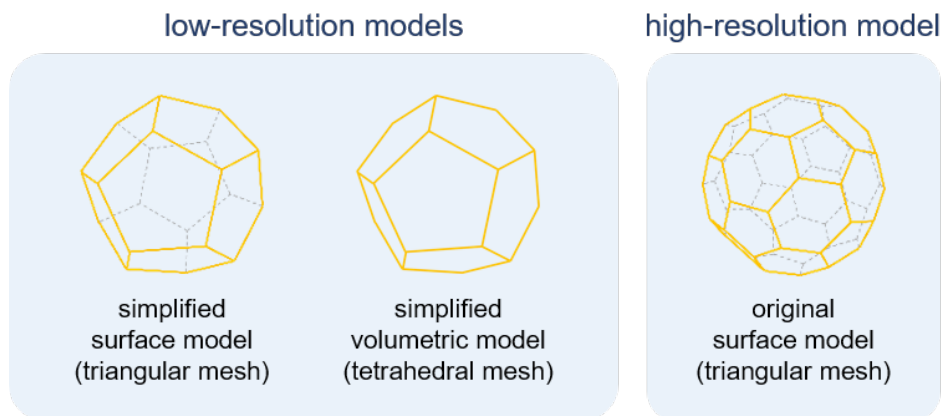
Figure 3. Different object models used for simulation (low-resolution models) and visualization (high-resolution